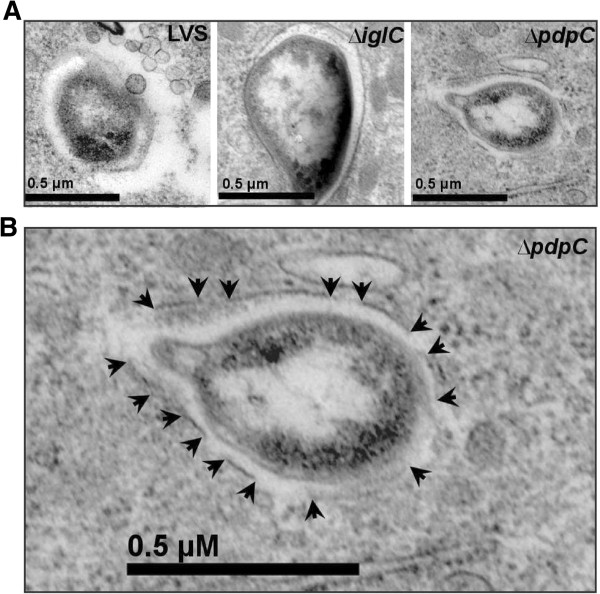
Electron micrographs of J774 macrophages infected with F. tularensis. (A) Cells infected with LVS, the ΔpdpC mutant, or the ΔiglC mutant. (B) A close-up of the ΔpdpC micrograph from A. Black arrows indicate the borders of the remaining vacuolar membranes surrounding the intracellular bacterium.